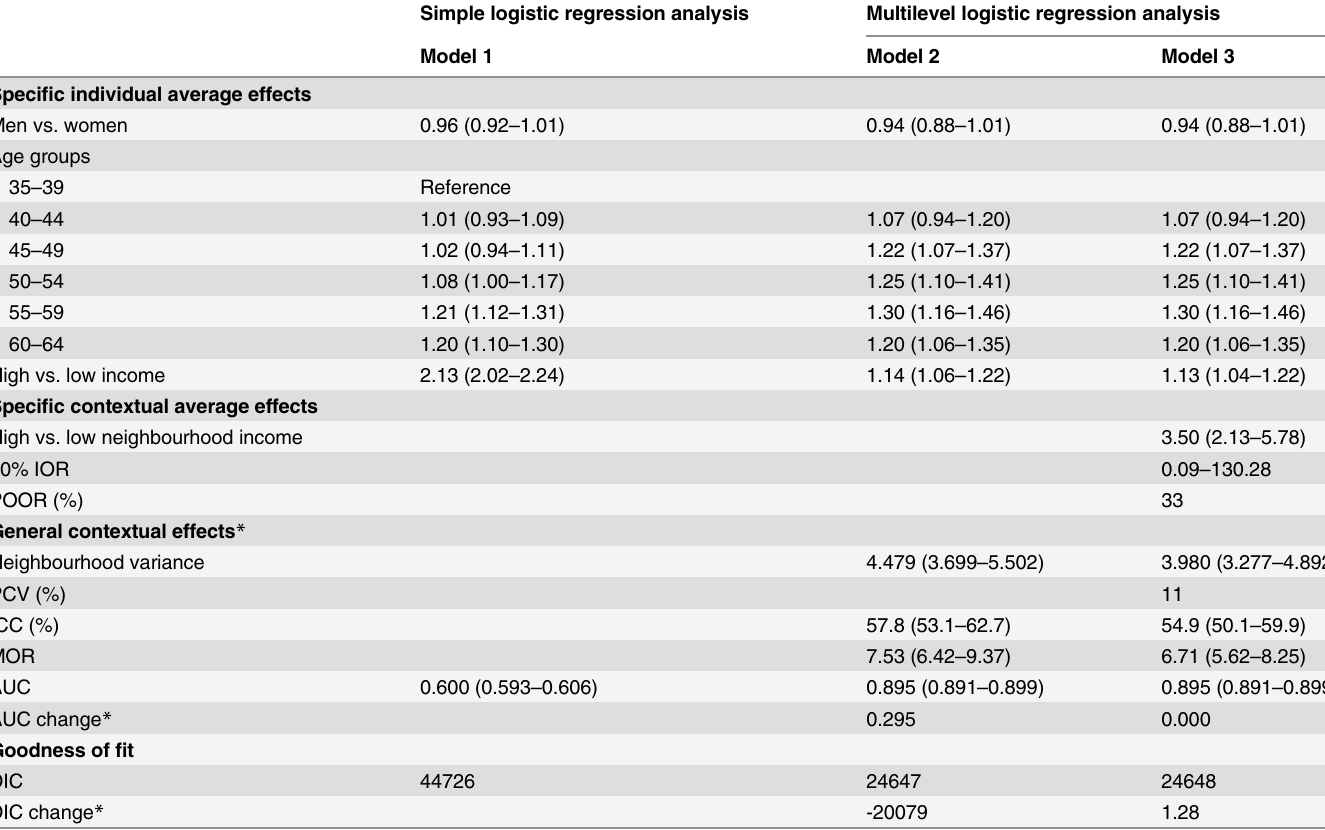
Table 3. Multilevel logistic regression analysis of choosing a private versus a public specialist in the 35 – 65 year-old population of Malmö, 2006, Values are odds ratios (OR) and 95% confidence interval (CI) unless stated